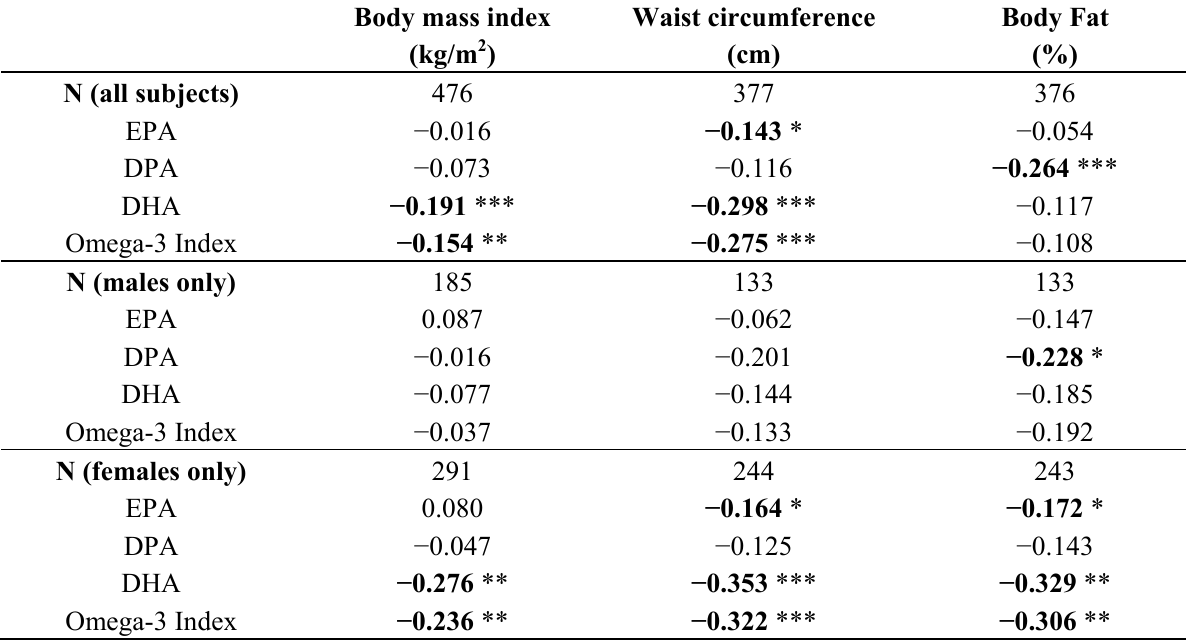
Table 3. Correlations between erythrocyte fatty acids and adiposity